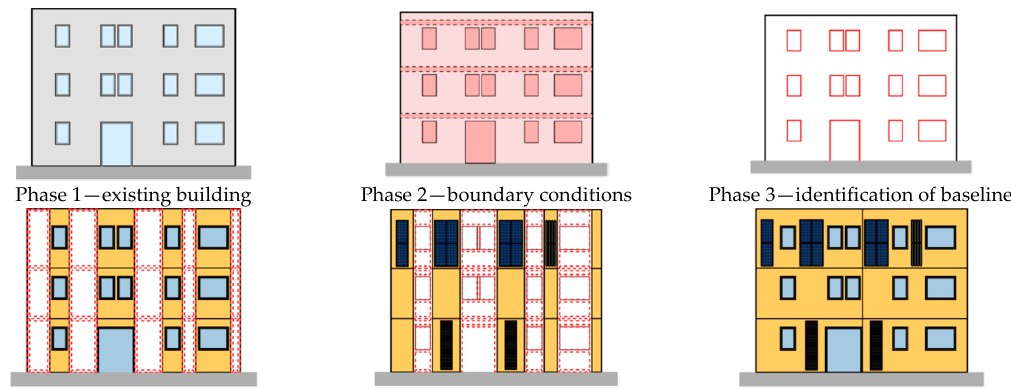
Figure 3. Phases for the design